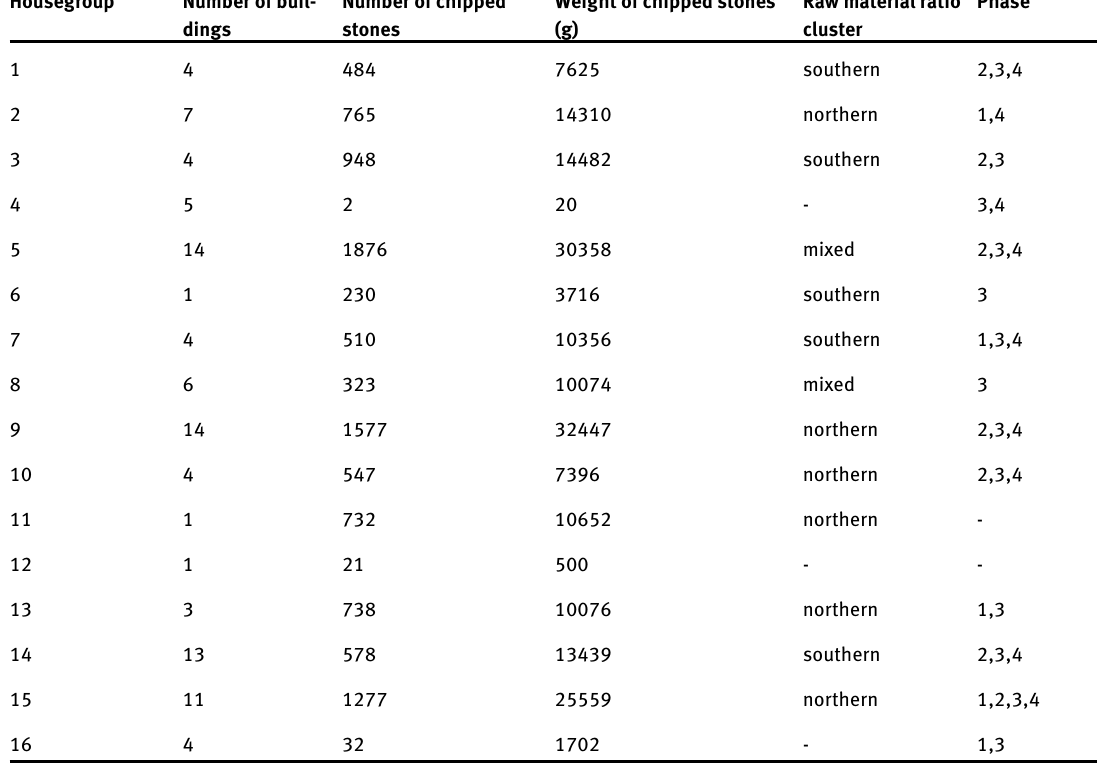
Table 2: Attributes of the house